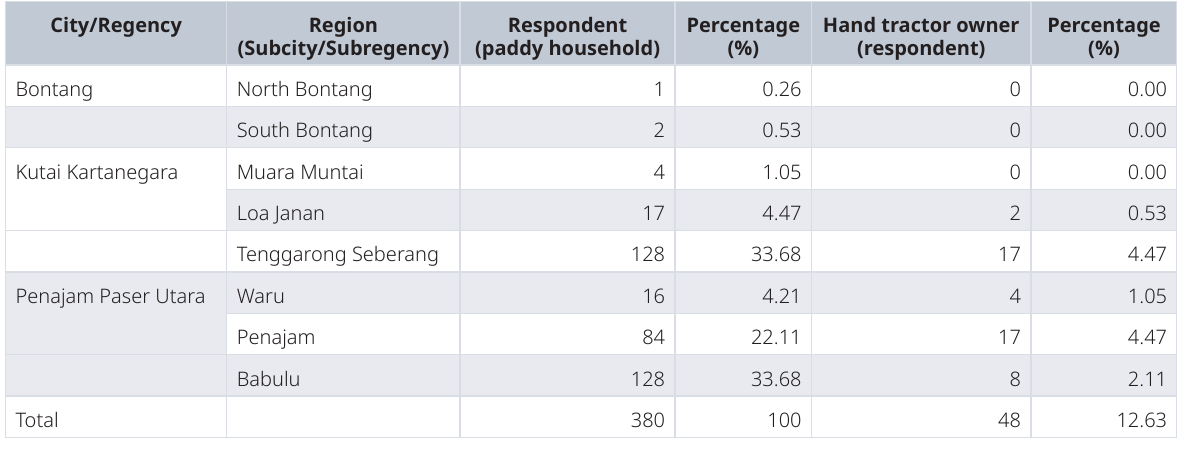
Table 2. Number of respondents who were hand tractor owners in East Kalimantan the year 2014.